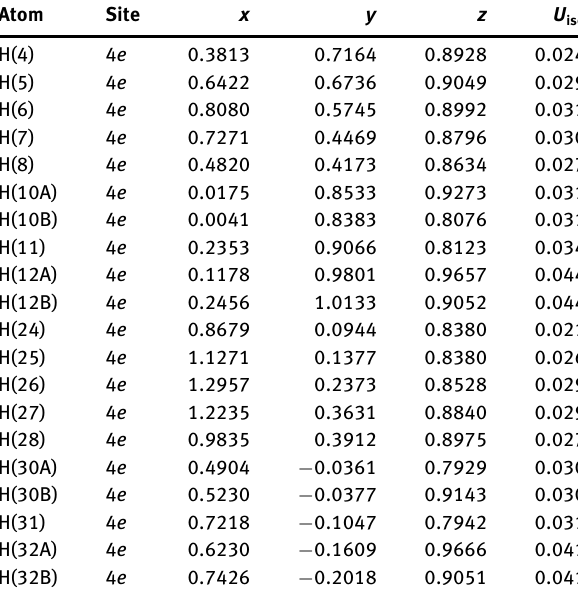
Table 2: Fractional atomic coordinates and isotropic or equivalent isotropic displacement parameters (Å 2